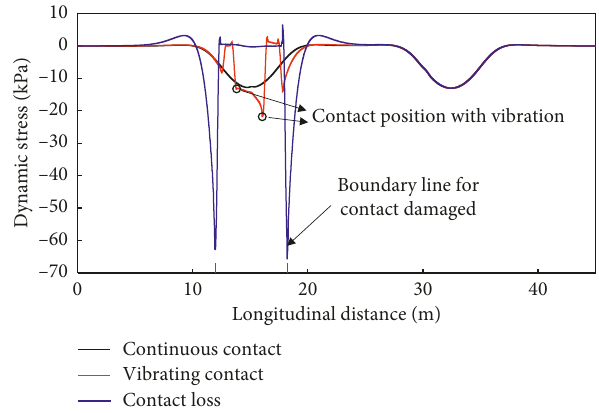
Figure 5: Dynamic stress distribution longitudinally on the roadbed surface in different contact states.